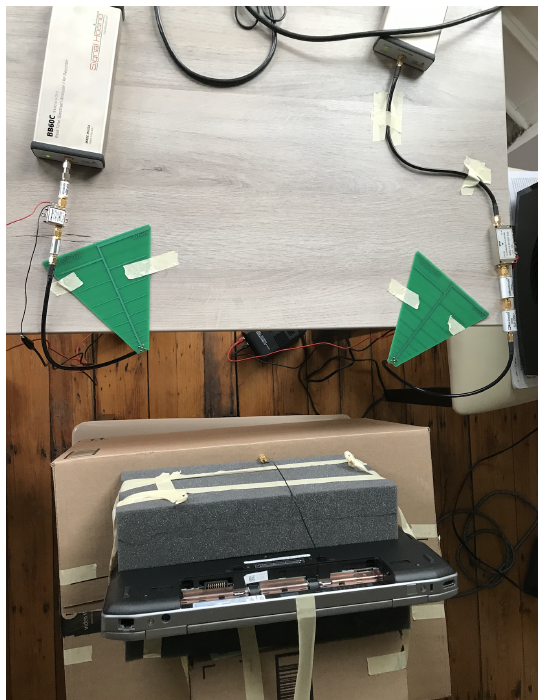
Figure 10. Wireless testbed (top-down view). The target device here is a laptop held vertically by blocks of foam. The distance between the antennas is 30 cm. This picture corresponds to the results presented in Section 7.1 at a distance of 35 cm.